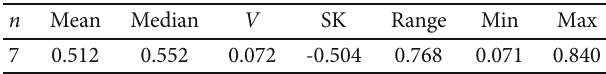
Table 10: Some descriptive analysis of data set